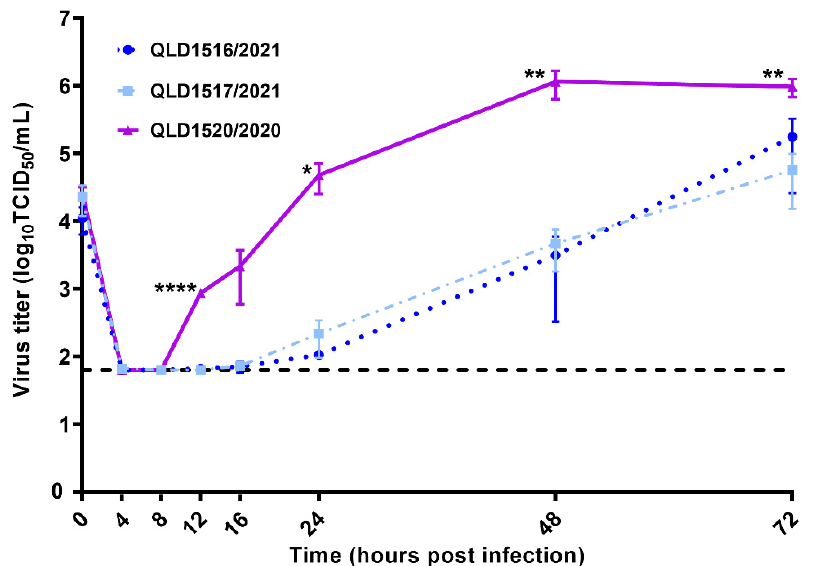
Figure 4. Kinetic replication curves (mean ± SD) of SARS-CoV-2 VOCs following infection of Vero E6 cells at a m.o.i. of 0.01. The black dotted horizontal line indicates the limit of detection (1.8 Log 10 TCID 50 /mL) of the TCID 50 assay. The virus titers at each time point were compared using one-way ANOVA and Tukey post-test. All comparisons between the two B.1.1.7 VOCs, QLD1517/2021 and QLD1516/2021, were not significant. Significant differences between QLD1520/2020 and the two B.1.1.7 VOCs are denoted as * p < 0.05, ** p < 0.01, and **** p < 0.0001.